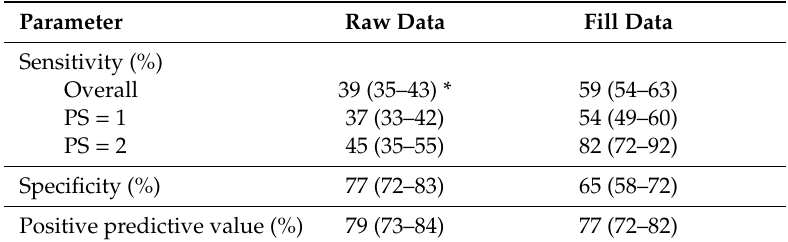
Table 7. Sensitivity, specificity, and positive predictive value (%) of sensor-derived panting states (minute by minute) compared to observed panting score (PS) for raw and fill datasets.